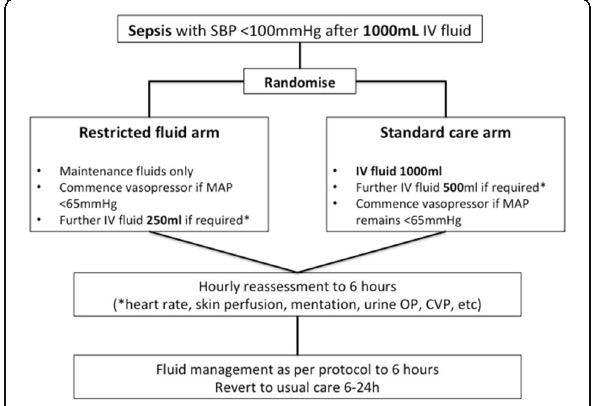
Fig. 1 (abstract P21). Summary of trial